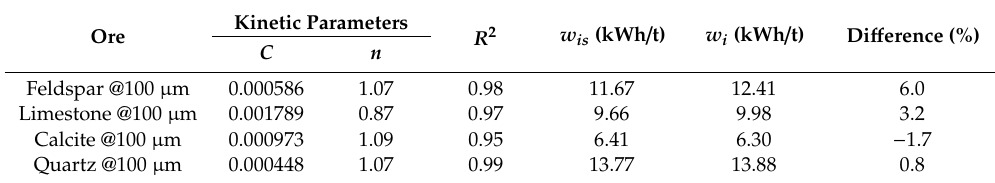
Table 1. Comparison between Work Indexes for pure gangue components and reference size 100 µ m, obtained through the standard procedure and the simulation ( w i = Work Index; w is = simulated Work Index).